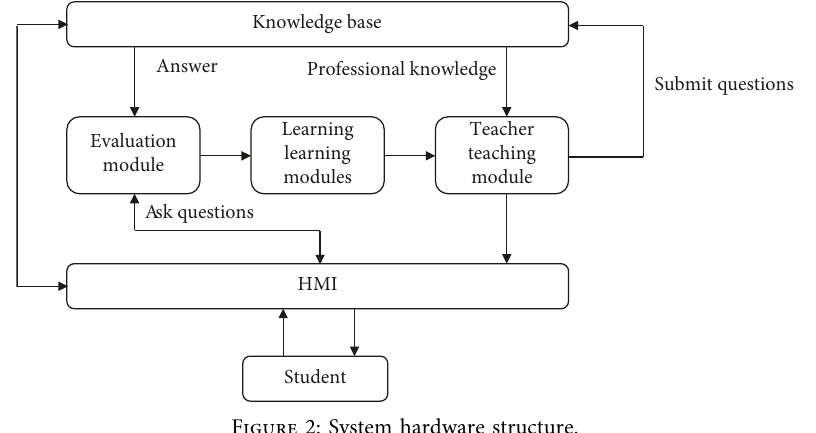
Figure 2: System hardware structure.